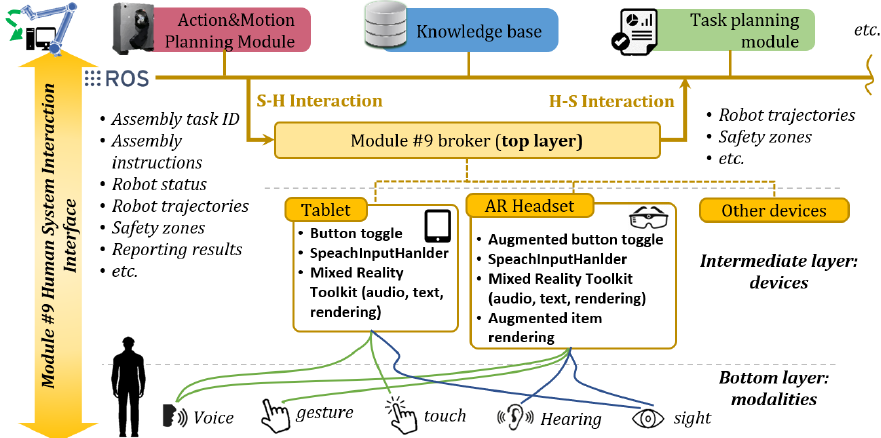
Figure 6. SHAREWORK’s Human-System interaction module